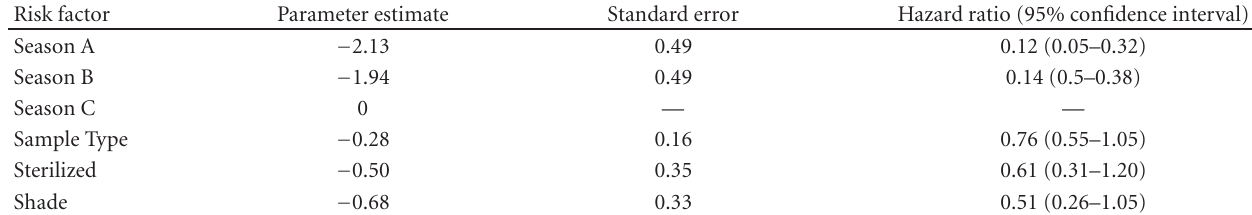
Table 4: Cox’s proportional hazard regression model for persistence of M. bovis over three di ff erent sampling periods (Fall/Winter “A”, Winter/Spring “B” and Spring/Summer “C”) or seasons.